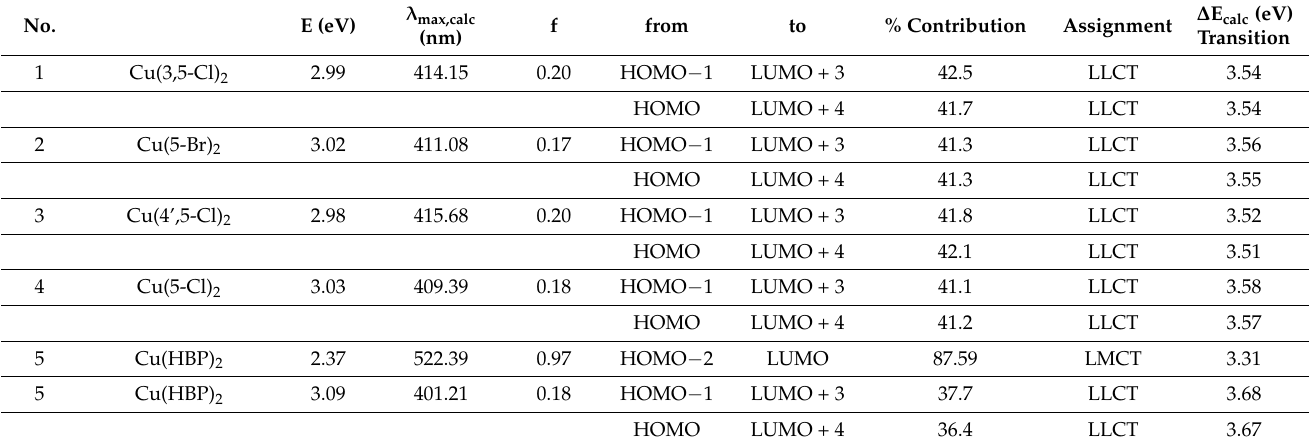
Table 2. Computed maximum wavelengths ( λ max,calc ), transition energy ( ∆ E in eV), oscillator strength (f) and assignments of main transitions involved in the excitation of Cu(L) 2 complexes ( 1 )–( 9